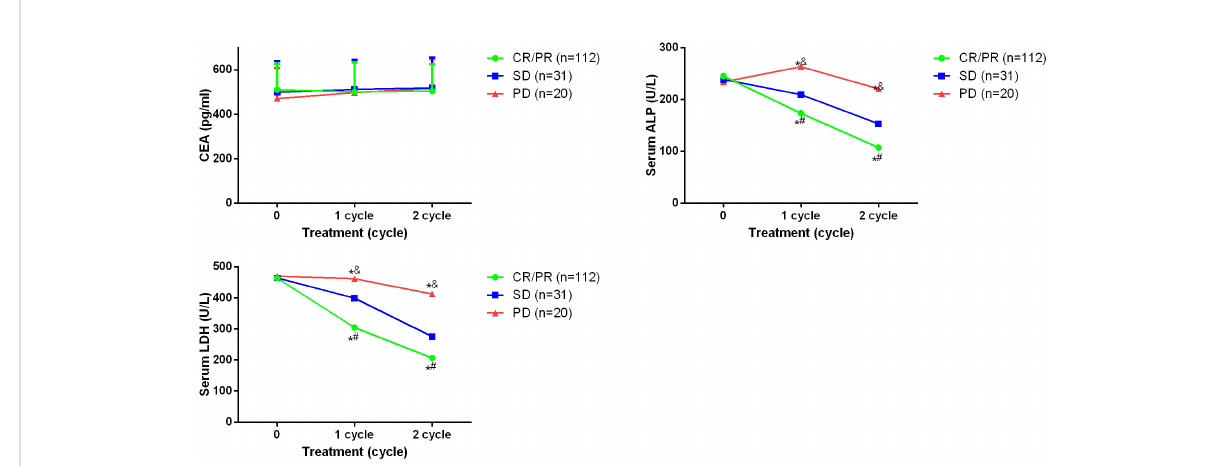
FIGURE 3 Serum levels of CEA, ALP and LDH in osteosarcoma patients before and after 2 cycles of the treatment. * p < 0.05 vs PD, # p < 0.05 vs SD, & p < 0.05 vs CR/PR. Comparison for continuous data were analyzed by t test (paired or unpaired) or Mann-Whitney U